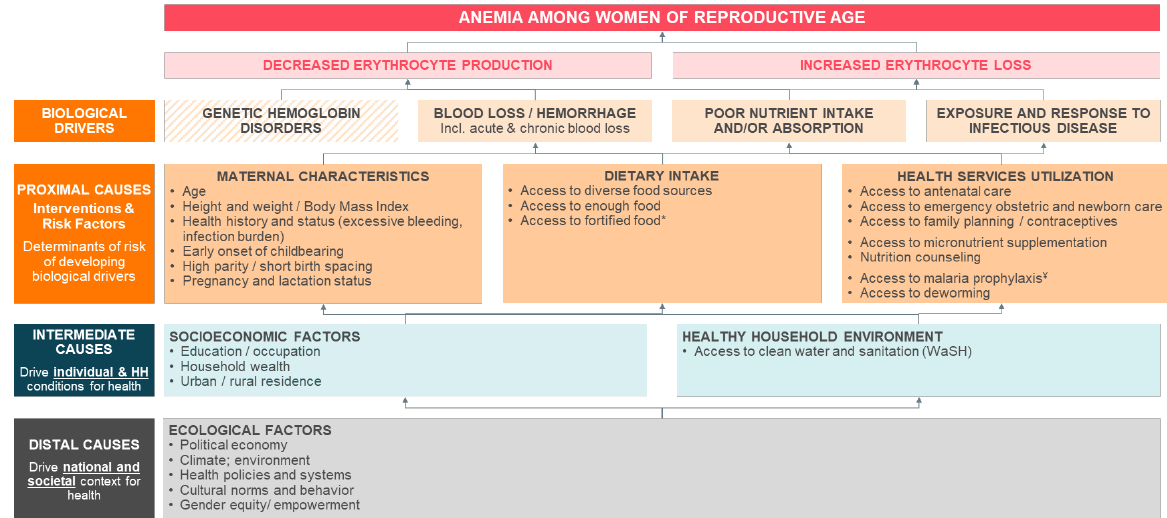
Figure 2. Conceptual framework of maternal anemia determinants. Determinants include those identified during the systematic review process. * Including from large-scale food fortification programs. ¥ Including insecticide-treated mosquito nets (ITN) and intermittent preventive treatment of malaria in pregnancy (IPTp).